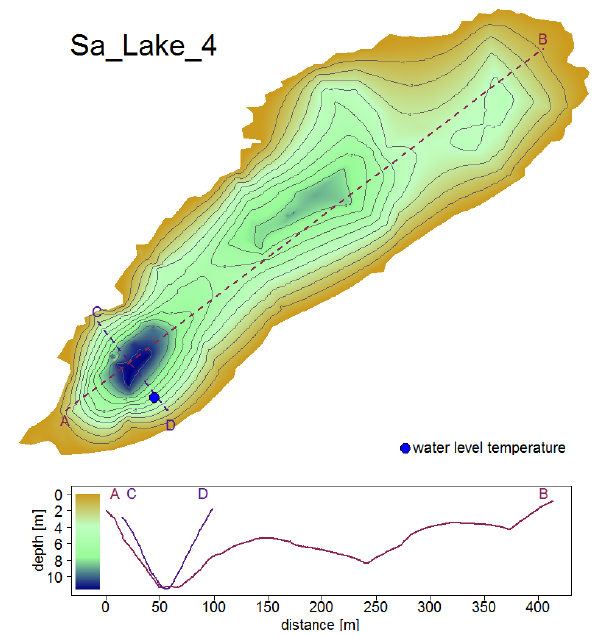
Figure A4. Bathymetry and cross sections of Sa_Lake_4 with loca- tion of